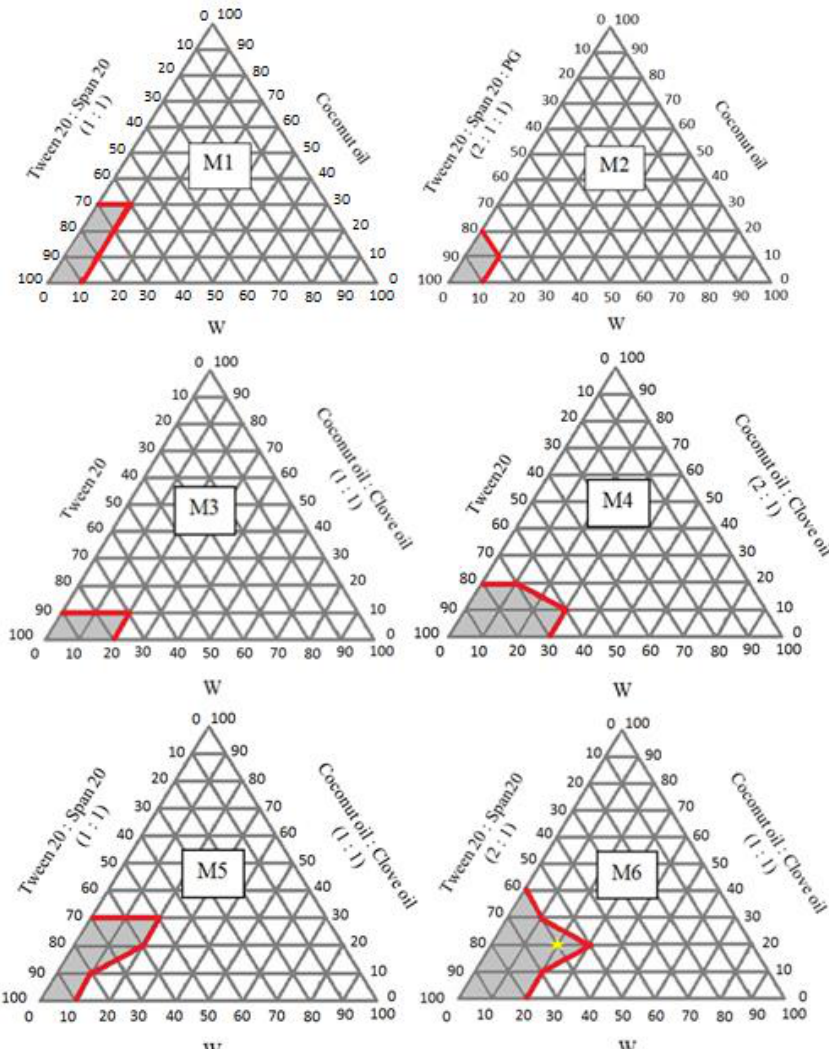
Figure 2. Pseudo-ternary phase diagrams M1 – M6. Table 4. Physical properties of the transparent microemulsion in the M6 diagram.